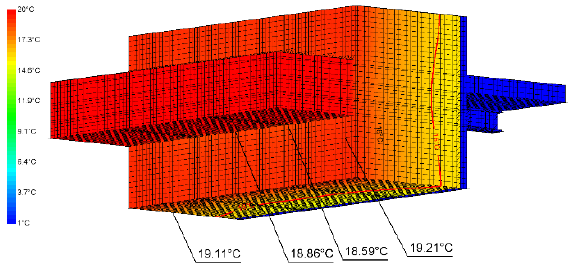
Figure 25. Internal surface temperature distribution field on the wall and deck—bottom view.